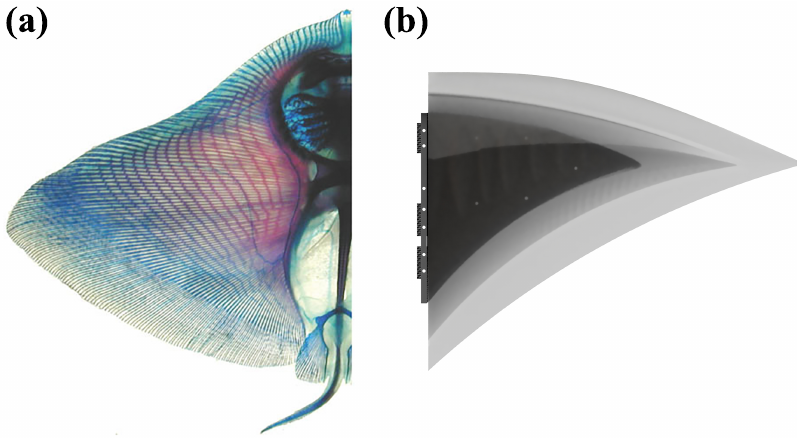
Figure 1. Comparison of the flapping wing of biological and bionic manta rays. ( a ) Cleared and stained embryo of Gymnura marmorata. Reprinted/adapted with permission from Ref. [9]. Copy- right 2005 John Wiley and Sons. ( b ) the soft material-based flapping wing